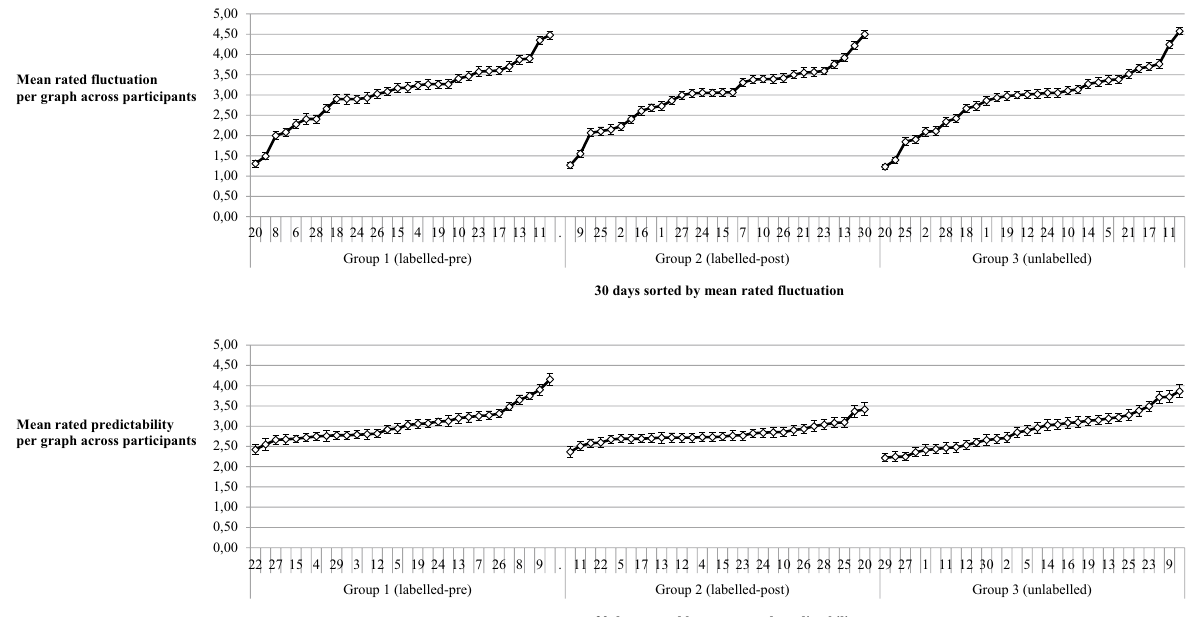
Fig. 4 Consistency of fluctuation and predictability ratings across the participants for each individual graph. Error bars depict the standard errors in the ratings of each individual graph in one specific